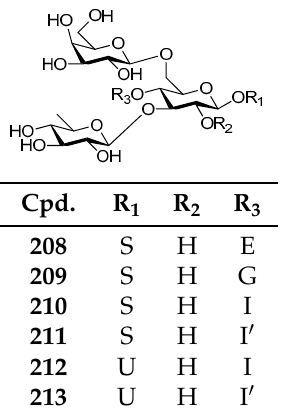
Figure 33. Structures of compounds 208 – 213 .